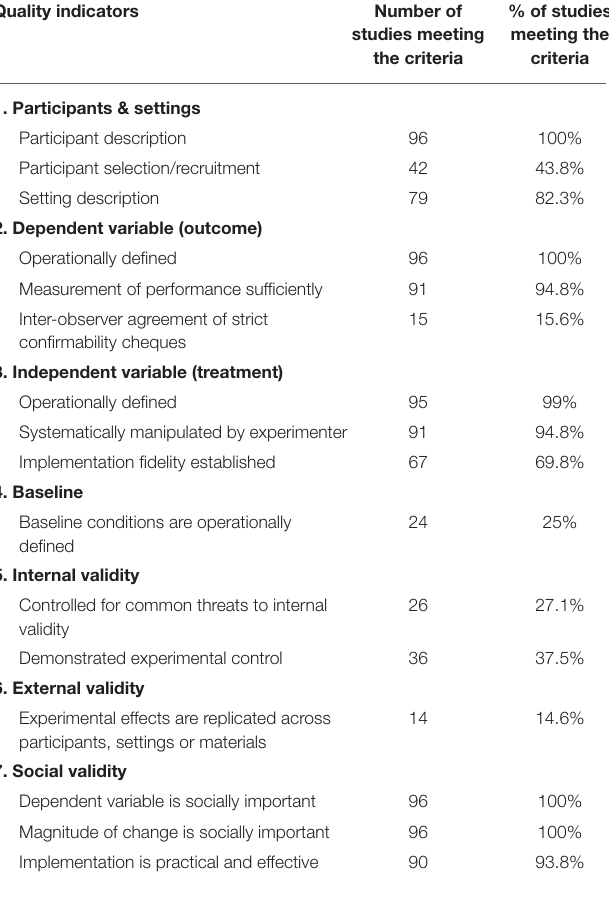
TABLE 2 | Rigour assessment of studies on game-based learning for learners with disabilities. Quality indicators